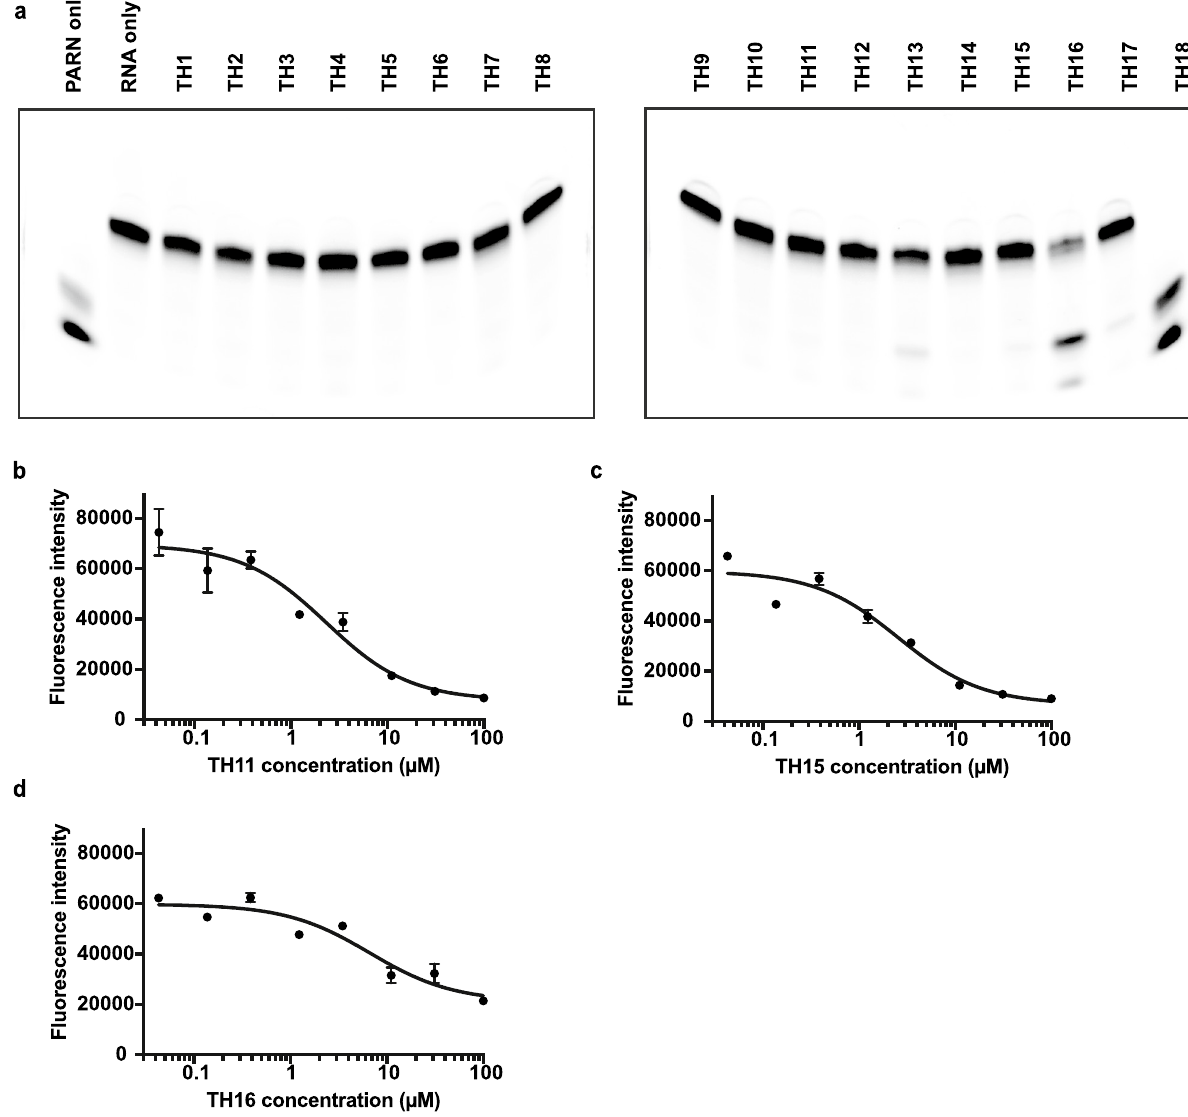
Figure 6. Testing high-throughput screening hits using gel assay. ( a ) Gels illustrating inhibitory effects of different drugs on PARN 1-430 . The reaction was performed the same as the fluorescence assay, heat inactivated, then loaded and visualized on gels. Full gels are presented in Supplementary Fig. S1. ( b ) Dose-response curve of TH11 on PARN 1-430 . ( c ) Dose-response curve of TH15 on PARN 1-430 . ( d ) Dose-response curve of TH16 on PARN 1-430